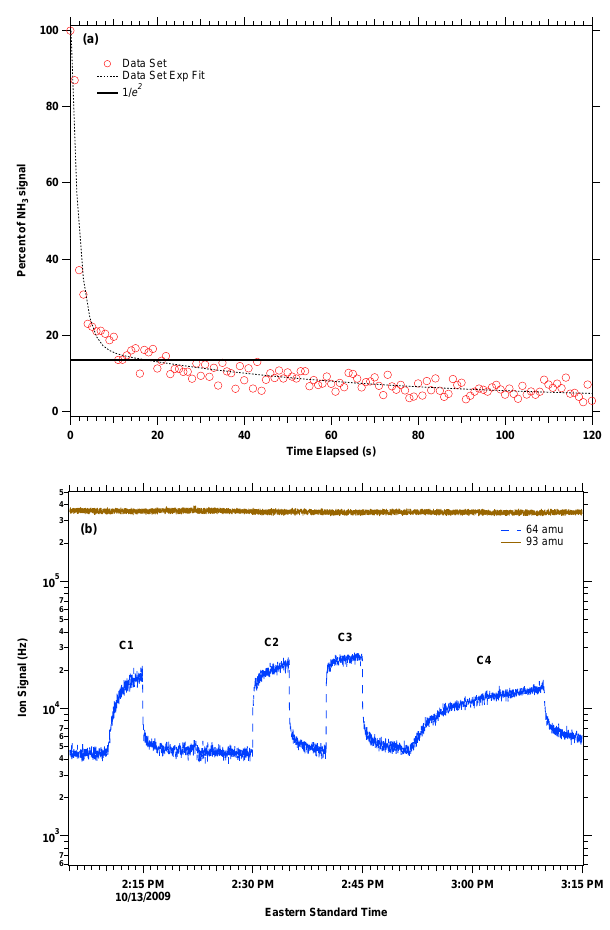
Fig. 3. (a) Signal decay after removal of calibration. One data set was used to calculate the time response of the CIMS instru- ment. The data set was for a sensitivity of 24.5Hz/pptv (maxi- mum signal was 25000Hz). The black dotted line represents dou- ble exponential fits for the data set and the black solid horizontal line 1/ e 2 decay. (b) A measurement sequence, showing four dif- ferent calibration measurements. Raw ion signals taken with a 1s time resolution are shown here. (C 2 H 5 OH) 2 H + , 93amu (brown); (C 2 H 5 OH)NH + , 64amu (light blue dashed). C1 indicates the cali- 4 bration measurements made using only 1sccm of 0.8ppbv NH 3 cal- ibration gases, C2 using 1sccm of 0.8ppbv NH 3 calibration gases and an additional 50sccm of N 2 , C3 using 1sccm of 0.8ppbv NH 3 and an additional 100sccm of N 2 , and C4 using 0.4ppbv NH 3 and an additional 100sccm of N 2 through the flow